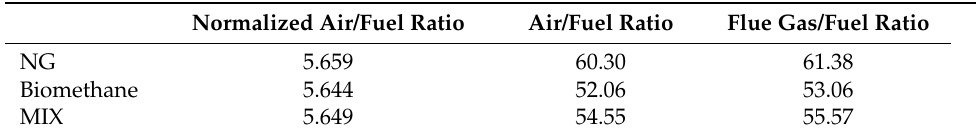
Figure 8. Fluidized bed type sand dryer (adapted from [39]). Table 3. Air/fuel ratio, flue gas/fuel ratio for NG, biomethane and MIX (X = 0.698) to maintain 500 ◦